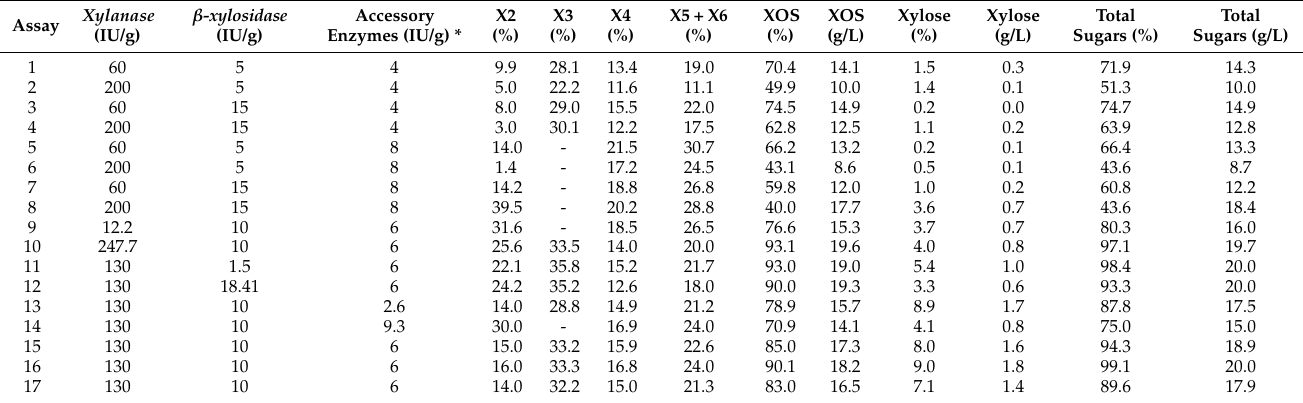
Table 1. Experimental design to obtain the complete hydrolysis of xylan evaluating xylanse, β - xylosidase, and accessory